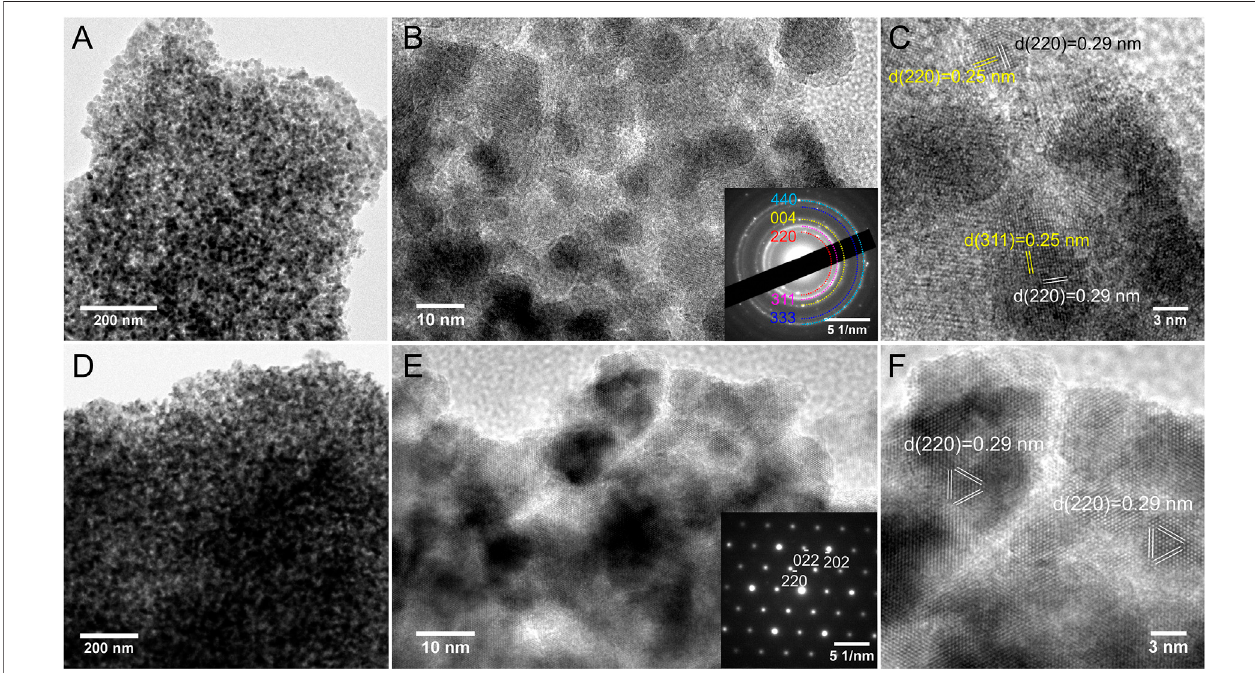
FIGURE9| TEManalysesofType-7 (A – C) andType-8 (D – F) nanometer-sized magnetiteaggregates. (A – C) Randomlyorientedmagnetitecrystalaggregates: (A) low-magni fi cation TEM image, (B) HRTEM image of many particles with the corresponding SAED pattern (inset), and (C) HRTEM image of several particles with Miller indices. (D – F) Uniformly oriented magnetite crystal aggregates: (D) low-magni fi cation TEM image, (E) HRTEM image of many particles with the corresponding SAED pattern (inset) and (F) HRTEM image of several particles with Miller indices.